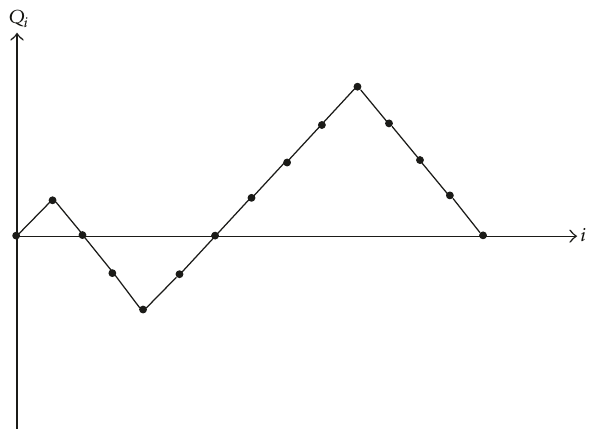
Figure 2: Generalized Dyck paths representing a possible electro- static field configuration of 14 parallel static charged